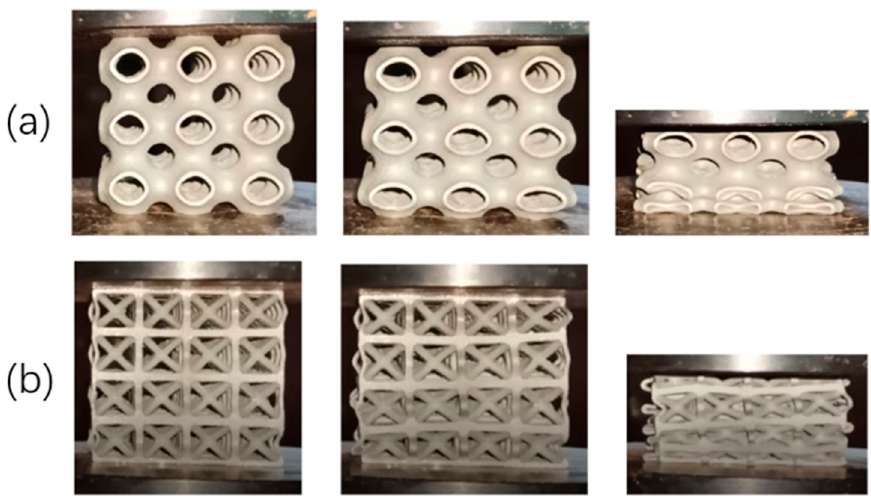
Figure 7. ( a ) Primitive surface, ( b ) Bcc lattice structure, deformation under fixed strain.